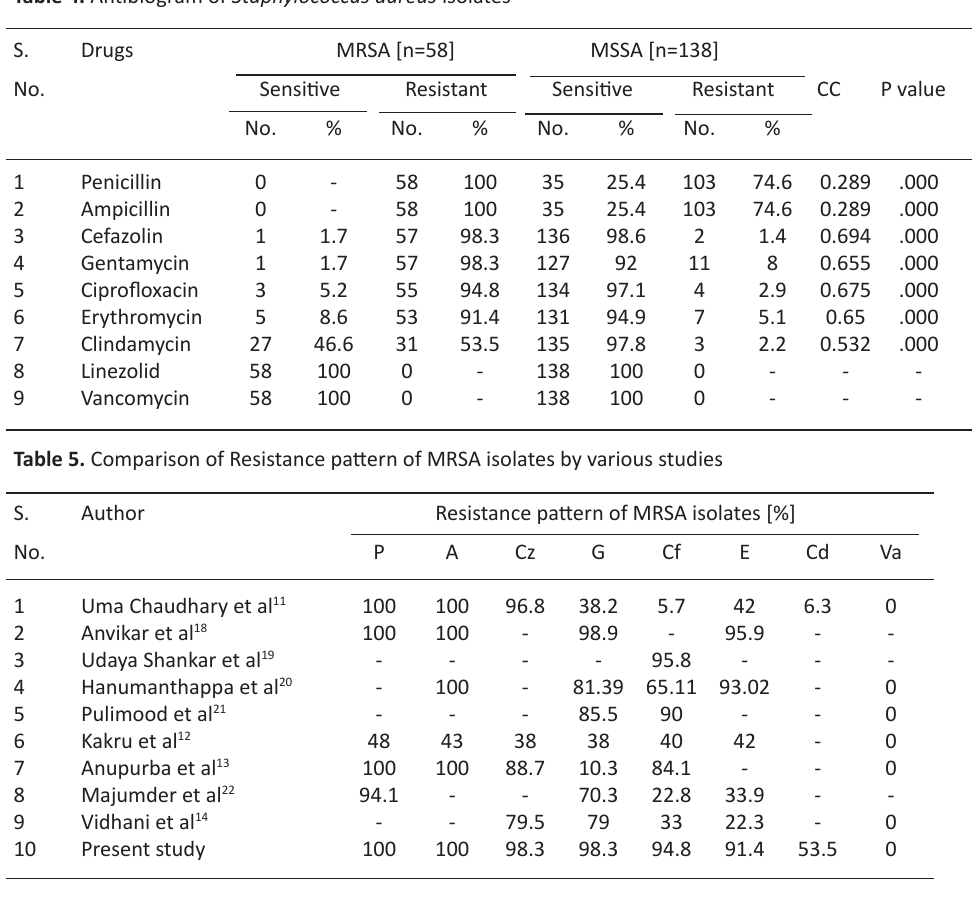
Table 4. Antibiogram of Staphylococcus aureus isolates S. Drugs